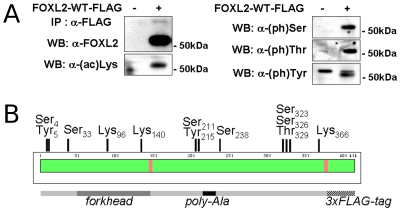
FOXL2 is acetylated and phosphorylated on multiple residues.A) Western blot following anti-FLAG immunoprecipitation of COS-7 lysates and SDS-PAGE. Cells were transfected with a mock vector (pcDNA3.1) or FOXL2-FLAG. Independent immunoblots were performed using anti-FOXL2 C-terminus antibody, mouse anti-acetyl-Lysine (Cell Signaling Technologies), mouse anti-phospho-Serine, anti-phospho-Threonine and anti-phospho-Tyrosine (Sigma-Aldrich), as indicated on the left of each image. B) Schematic representation of FOXL2 post-translational modifications identified by mass spectrometry. Immunoprecipitated FOXL2, in the form of a crude eluate or the isolated 51–52 kD band revealed by Coomasie staining, was digested using trypsin or chymotrypsin and analyzed using ESI-MS-MS with an Orbitrap analyser. Databases were searched with acetylation of lysines and phosphorylation of serines, threonines and tyrosines set as dynamic modification in addition of modification of cysteines by a carbamidomethyl or n-ethylmaleimide groups and oxidation of methionine that were due to sample preparation. FOXL2 sequence is represented by a green and red bars, the green color representing residues present in at least one high confidence peptide, whereas other residues are in red. The positions of the phosphorylated and acetylated residues in the FOXL2 sequence, based on the database search, are represented. Manual inspection revealed that the modification on serine 4 or tyrosine 5 is more likely a sulfation than a phosphorylation. Lower bar represents the position of the forkhead and poly-Alanine domains.